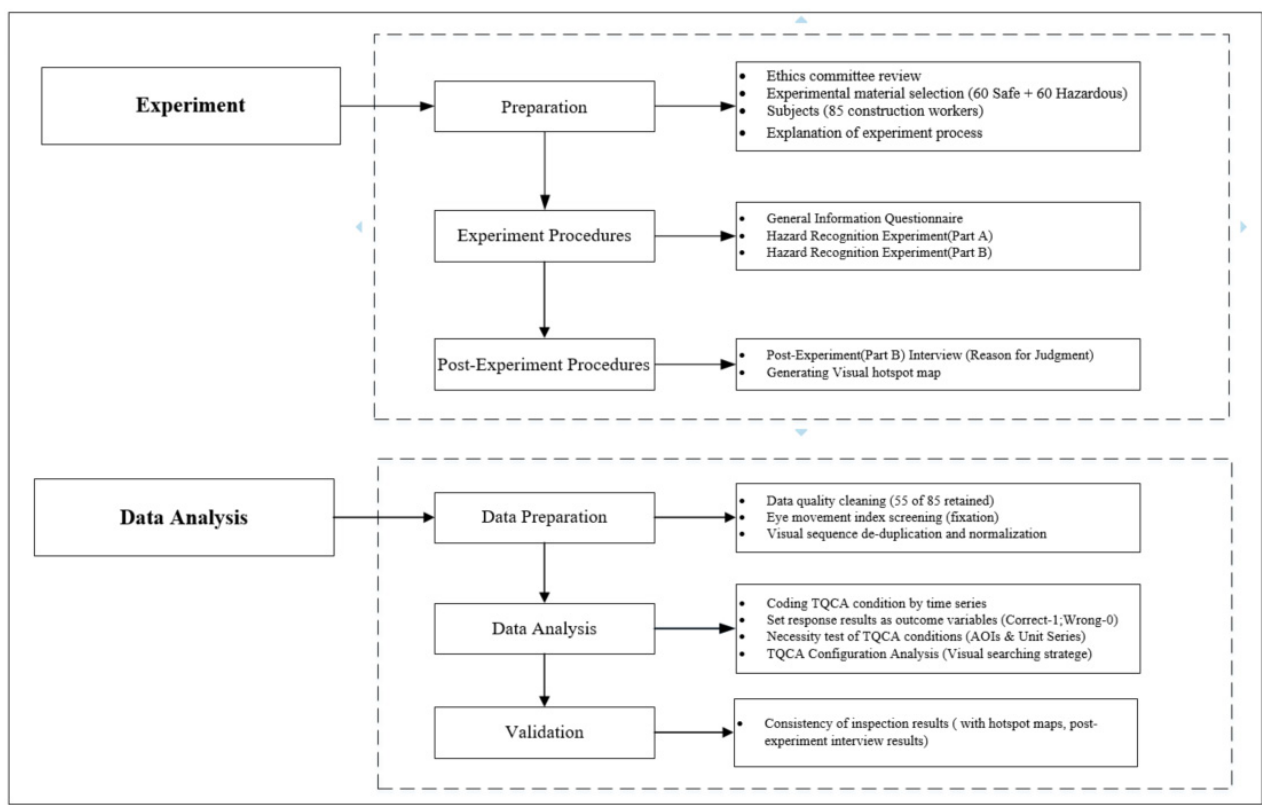
Figure 1. Graphic representation of the methodology.